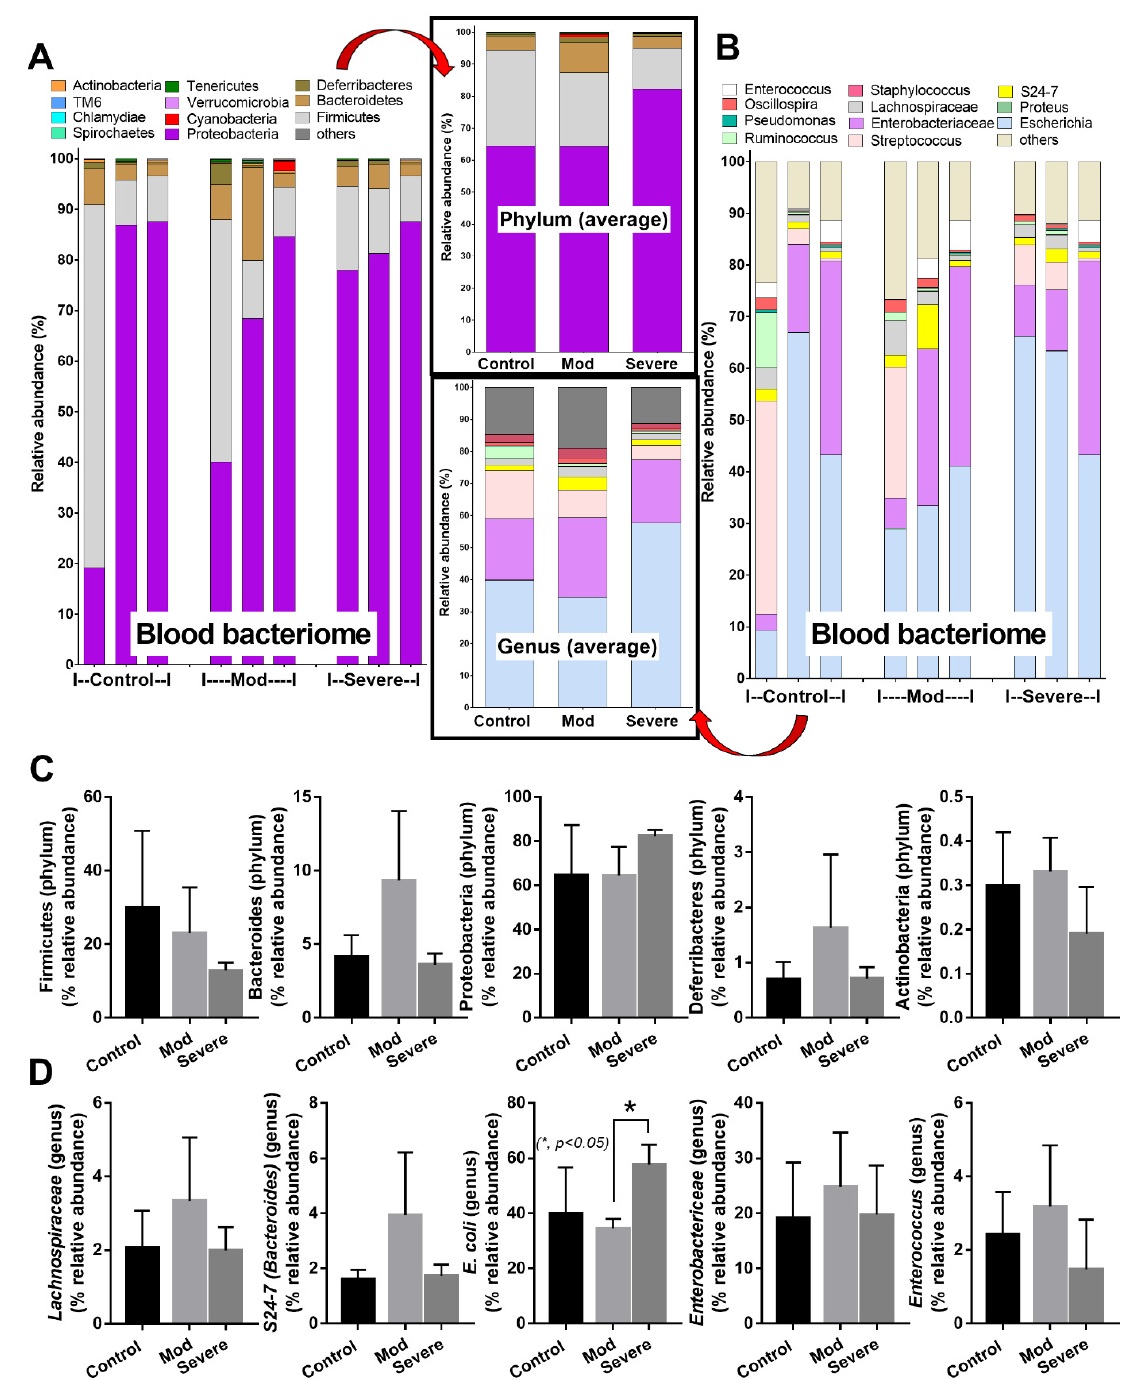
Figure 3. Blood microbiome analysis (blood bacteriome) from samples of healthy control (Control) and COVID-19 infection in moderate (Mod) and severe (Severe) conditions, as indicated by the phylum level analysis (with average value) ( A ), genus-level analysis, and average value ( B ). Graph presentation in phylum ( C ) and genus ( D ) analysis are demonstrated ( n = 3/group). *— p < 0.05 between the indicated groups using one-way ANOVA with Tukey’s